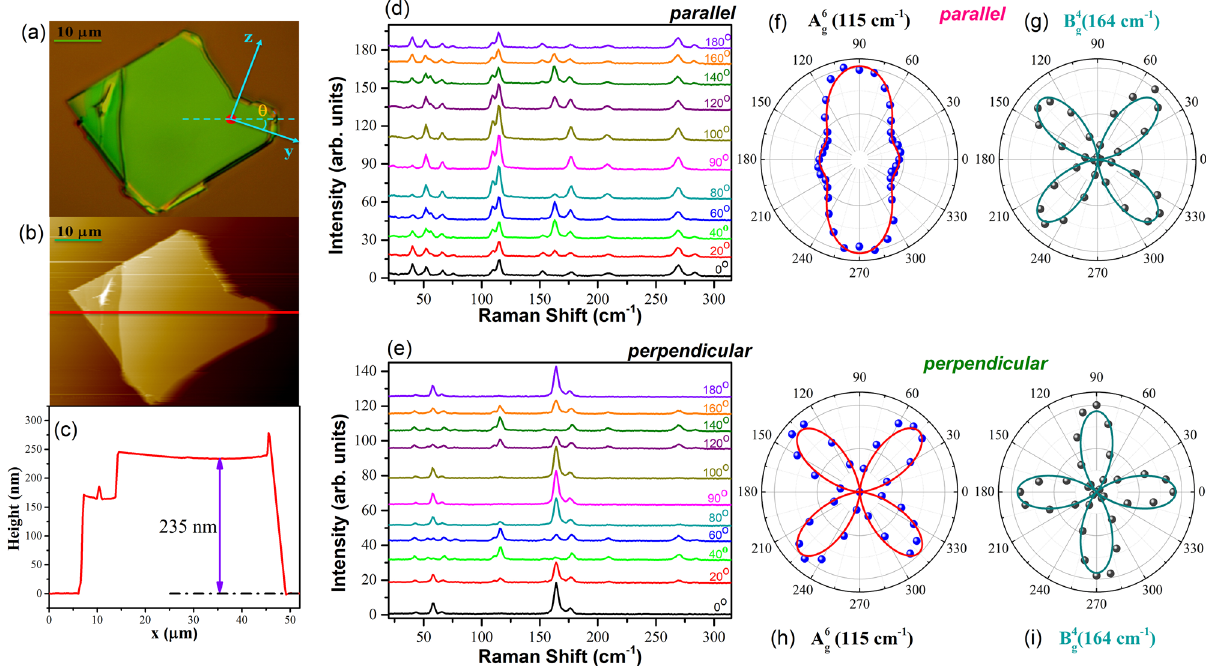
Figure 2. ( a ) Optical microscope image of the measured GaTe flake, where the crystal orientation and the angle θ between the polarization of the incident light and the y-axis were indicated. ( b,c ) AFM image and height profile of the GaTe flake. Polarization-resolved Raman spectra of a thick flake under ( d ) parallel and ( e ) perpendicular polarization configurations. Raman intensity polar plots of A modes under ( f,g ) parallel and ( h,i ) perpendicular polarization configurations, where solid lines represent fitted